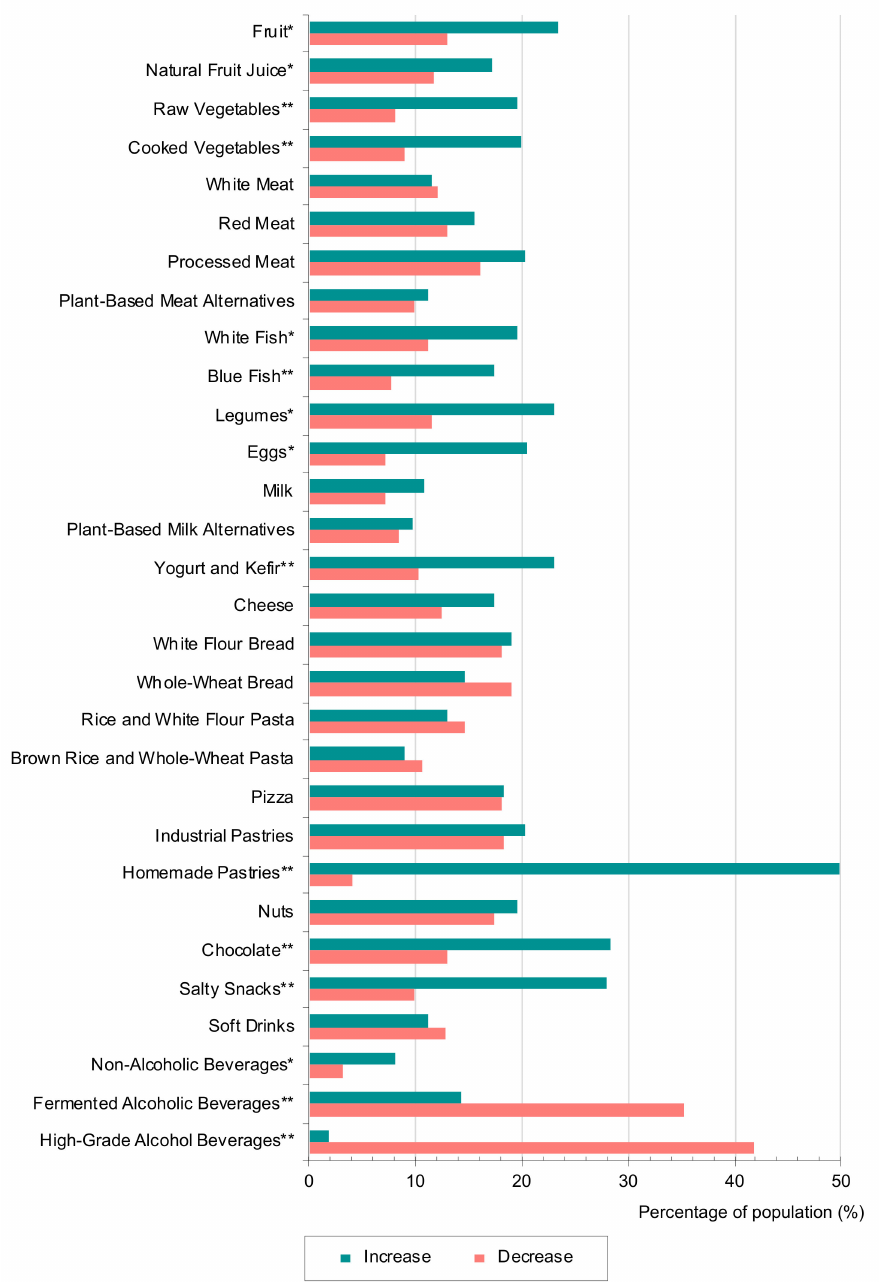
Figure 1. Percentage of population that reported a variation (increase or decrease) in the intake of each foodstuff during COVID-19 lockdown. People who reported no change in frequency of consumption are not represented in this figure. Statistically significant differences between food intake before and during COVID-19 lockdown period were assessed by a Wilcoxon test and are indicated with asterisks (* p < 0.05; ** p <